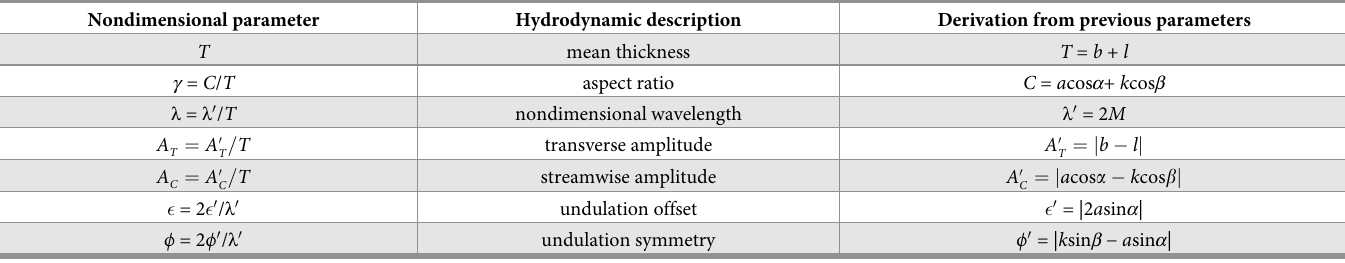
Table 1. Description of geometric